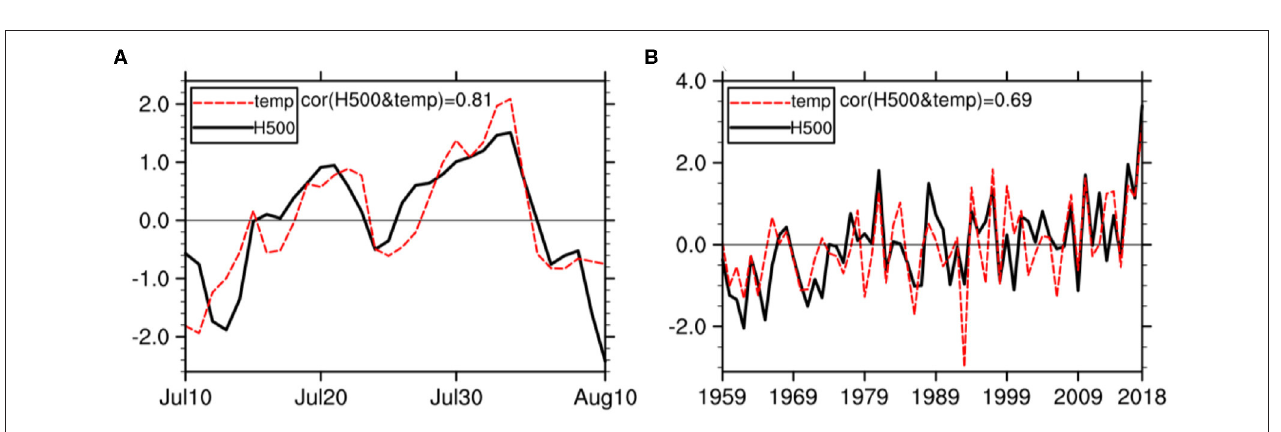
FIGURE 2 | July 18th-August 5th mean anomalies of the geopotential heights (contours, gpm) and 2m temperatures (shaded, ◦ C); the rectangle denotes the region that was primarily affected by this high-temperature process.